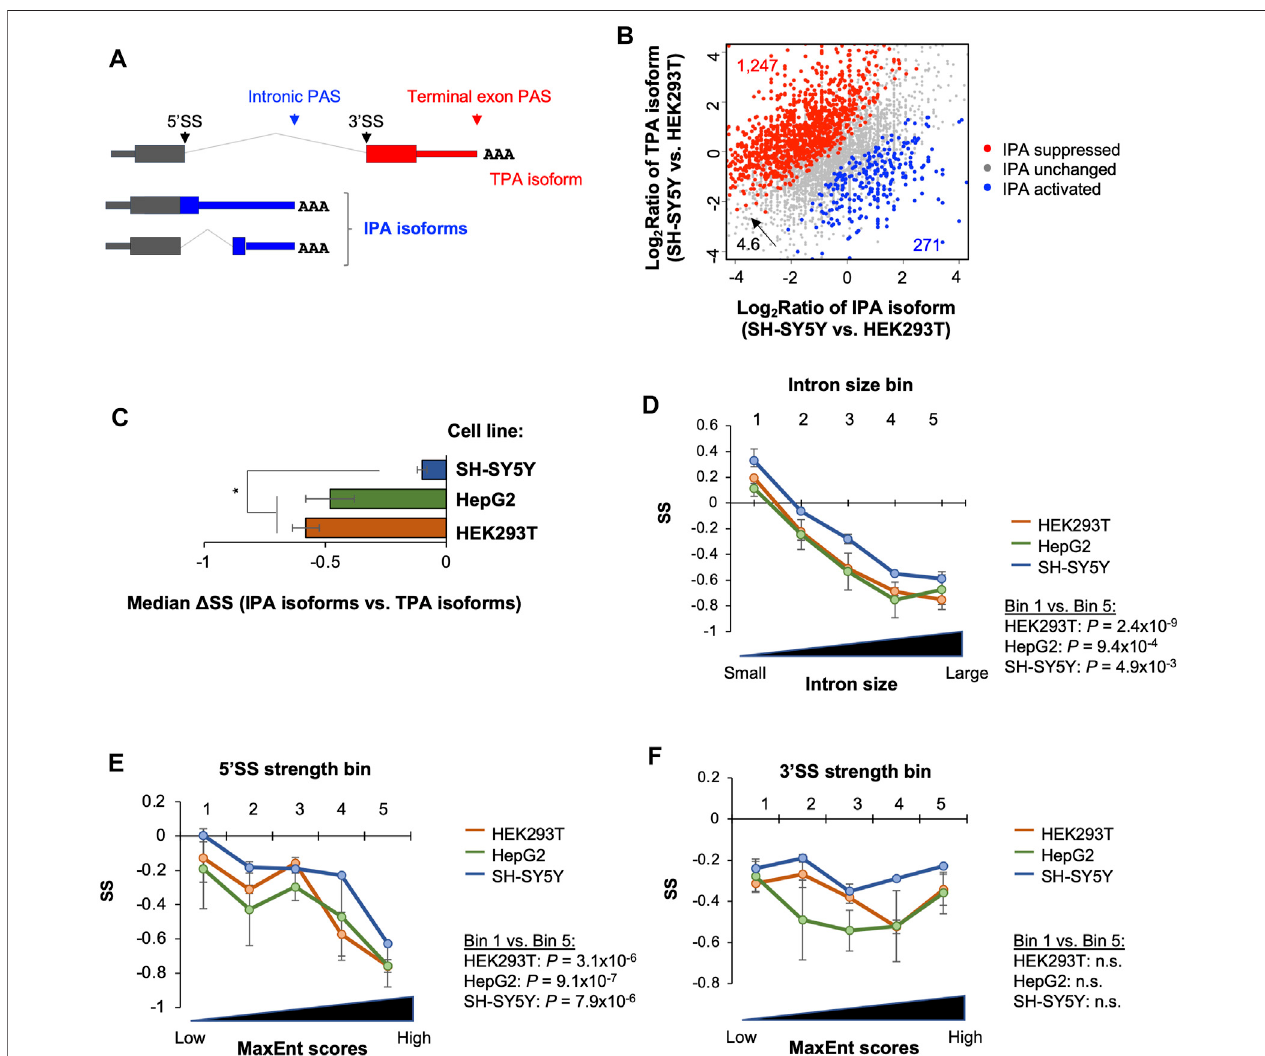
FIGURE 5 | Stability analysis of intronic polyadenylation isoforms. (A) Schematic of intronic polyadenylation (IPA) isoforms and 3 ′ -most terminal exon polyadenylation (TPA) isoform. (B) Comparison of IPA isoform stability with TPA isoform stability in three cell lines. (C) Median Δ SS between IPA and TPA isoforms in three cell lines. Signi fi cance is based on the Wilcoxon test comparing the cell lines. (D) Impact of intron size on IPA isoform stability. IPA isoforms are divided into fi ve equally sized bins based on the size ofintron containing theIPA site. P-value (Wilcoxon test) for signi fi cance ofdifference between bin 1 and bin 5in each cell lineis indicated. (E) AsinC,exceptthatIPAisoformsaredividedinto fi veequallysizedbinsbasedonthe5 ′ SSstrength(MaxEntscore)ofintroncontainingtheIPAsite.(F)Asin C, except that IPA isoforms are divided into fi ve equally sized bins based on the 3 ′ SS strength (MaxEnt score) of intron containing the IPA site. n.s., not signi fi cant ( p > 0.05, Wilcoxon